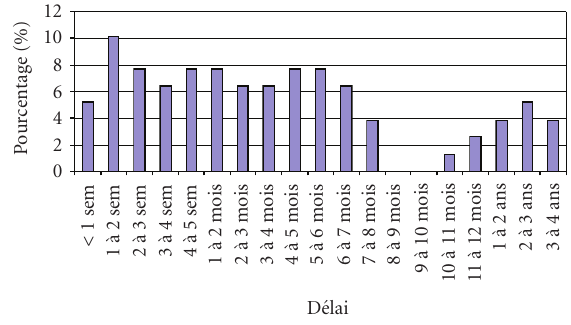
Figure 9: Time delay between initial diagnosis and first